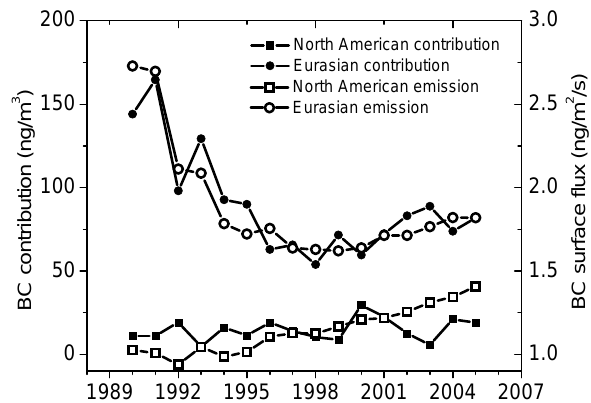
Fig. 4. Model estimated source contributions of BC from the North American and the Eurasian sectors based on the average of January and April from 1990 through 2005. The inter-annual changes in BC surface flux are show by two dashed